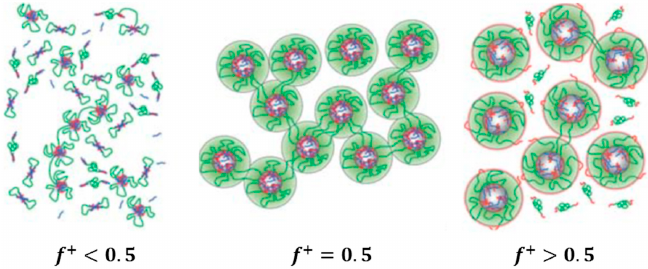
Figure 8. Schematics of the morphologies of solutions from SES and AH for excess negative charge, charge stoichiometry and excess positive charge for the concentrated regime. Adapted with permission from [39]. Copyright 2012 Royal Society of Chemistry.